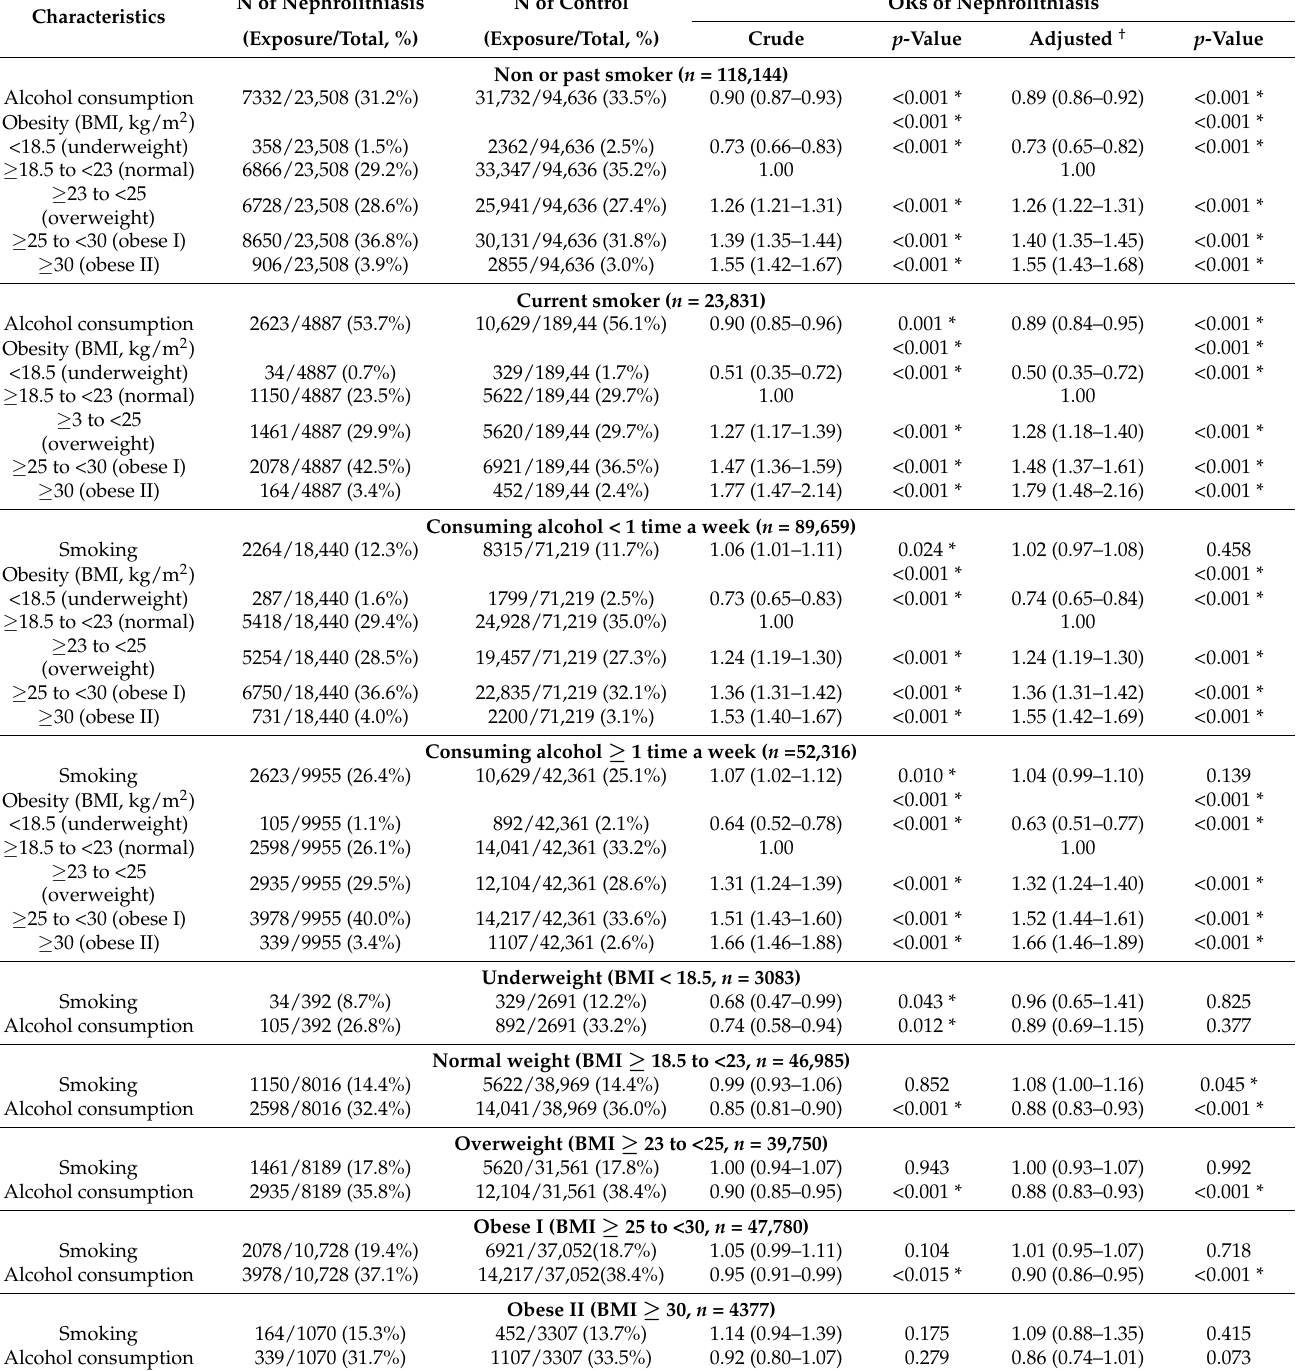
Table 4. Crude and adjusted odd ratios (95% confidence interval) of smoking, alcohol consumption, and obesity for nephrolithiasis in each